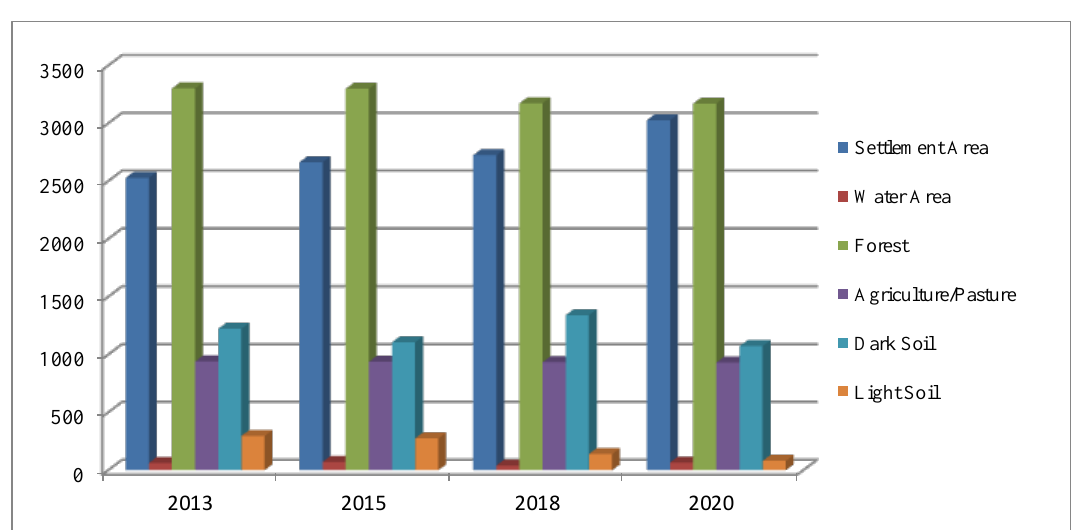
Figure 6. Land Use Chart for Working